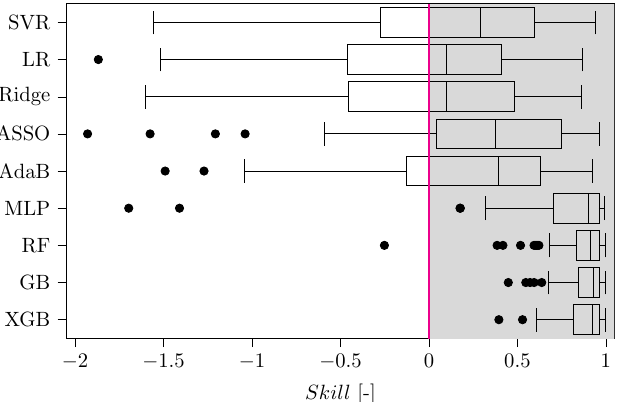
Figure 8. Results of the predictions of the ML model classes visualized by boxplots. Evaluations with a higher Skill (or a lower MSE ) compared to the Z–A model are highlighted by the gray shaded area in the